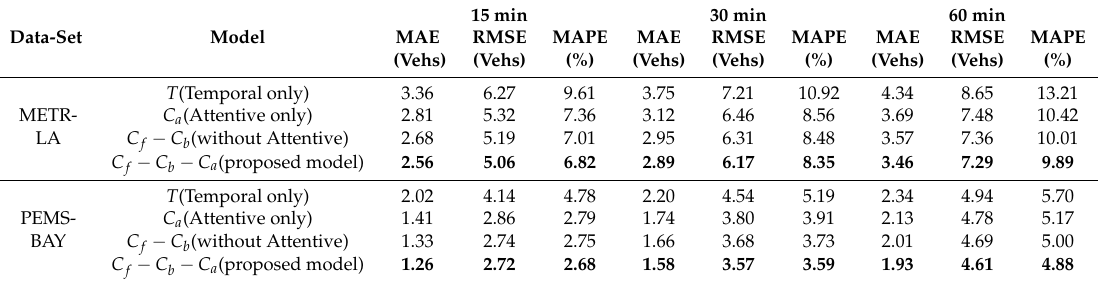
Table 3. The case study results of ST-TrafficNets with different MDC block configurations. All the MDC models surpass the temporal-only model largely. The attentive-only model is just little poorer than the forward-backward model. The forward-backward-attentive model achieves the best result. Data-Set